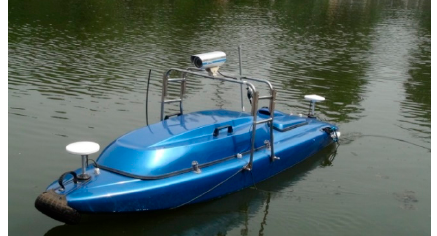
Figure 14. The USV system in our experiments. Table 1. Parameters of the USV in our experiment.